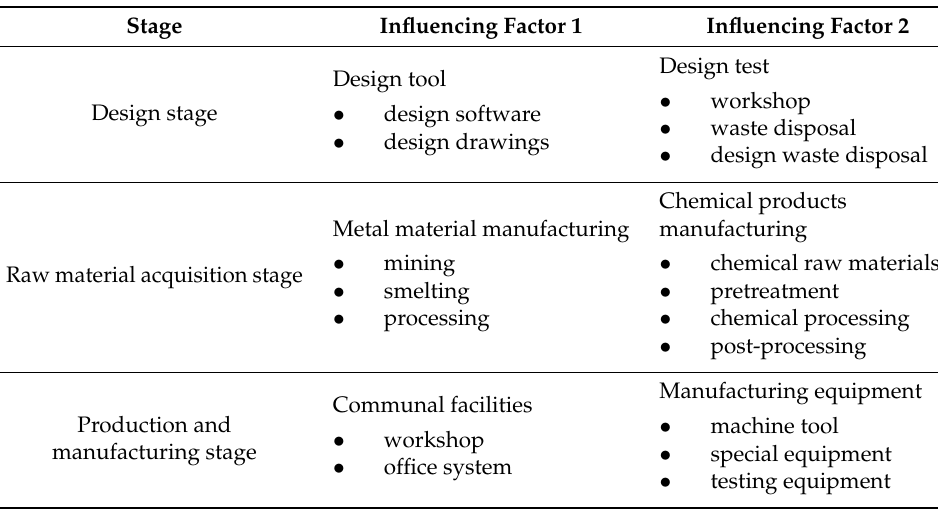
Table 3. The main LCA influencing factors of the wind turbine.